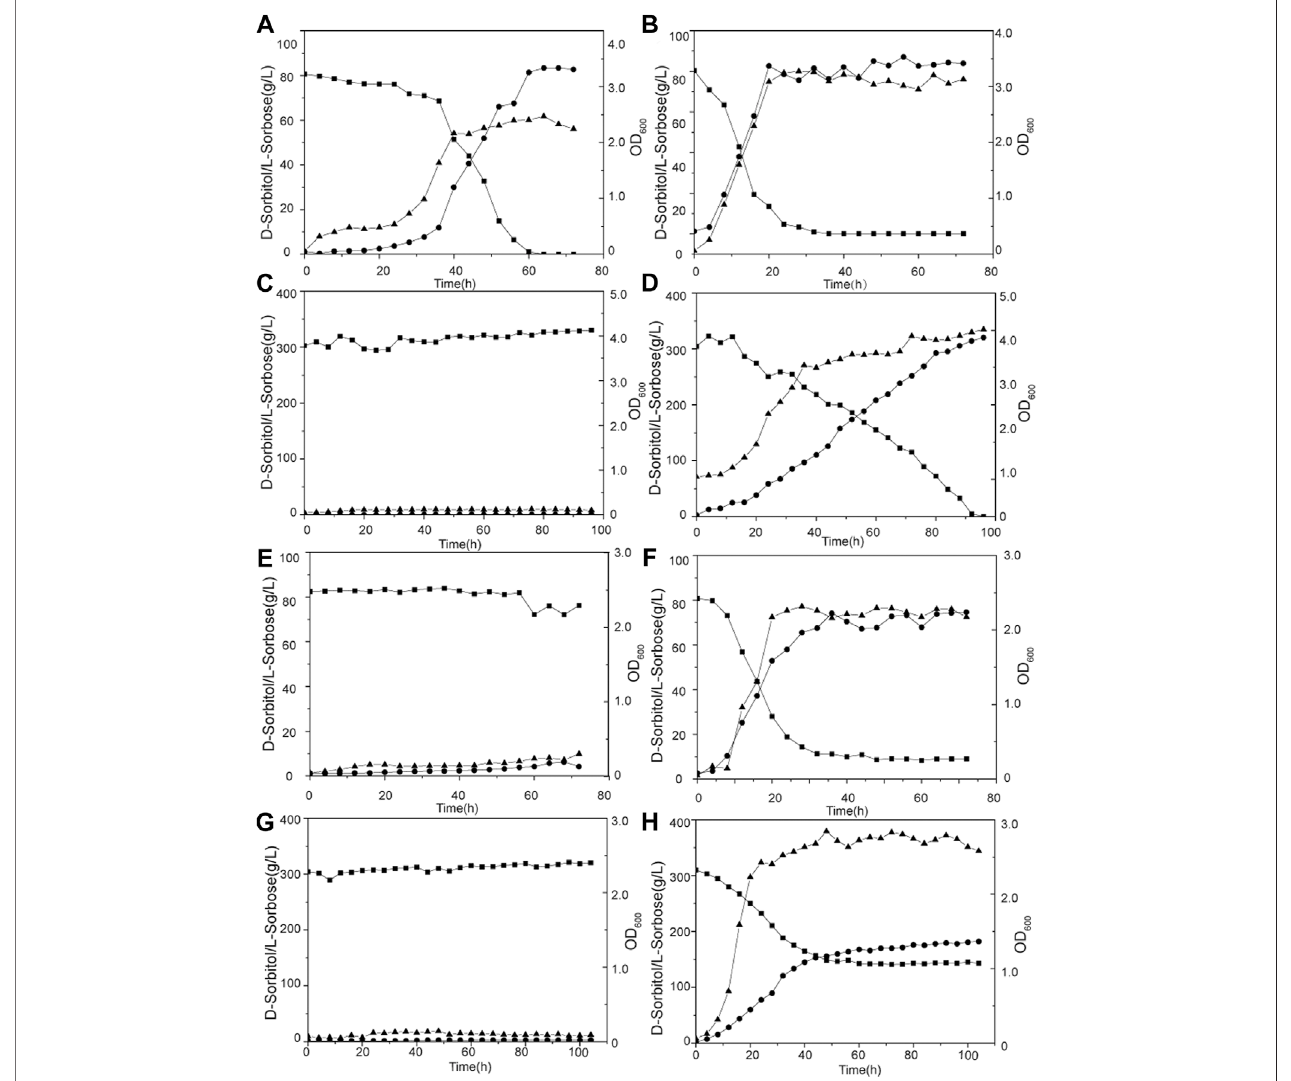
FIGURE7| Productionof L -sorboseby G.oxydans ina5-Lfermentor. (A) G.oxydans WSH-004in80 g/LofD-sorbitolat30 ° C; (B) G.oxydans MMC10in80 g/L of D-sorbitol at 30 ° C; (C) G. oxydans WSH-004 in 300 g/L of D-sorbitol at 30 ° C; (D) G. oxydans MMC10 in 300 g/L of D-sorbitol at 30 ° C; (E) G. oxydans WSH-004 in 80 g/L of D-sorbitol at 37 ° C; (F) G. oxydans MMC10 in 80 g/L of D-sorbitol at 37 ° C; (G) G. oxydans WSH-004 in 300 g/L of D-sorbitol at 37 ° C; and (H) G. oxydans MMC10 in 300 g/L of D-sorbitol at 37 ° C. Square: D-sorbitol; circle: L -sorbose; and up-triangle: OD 600